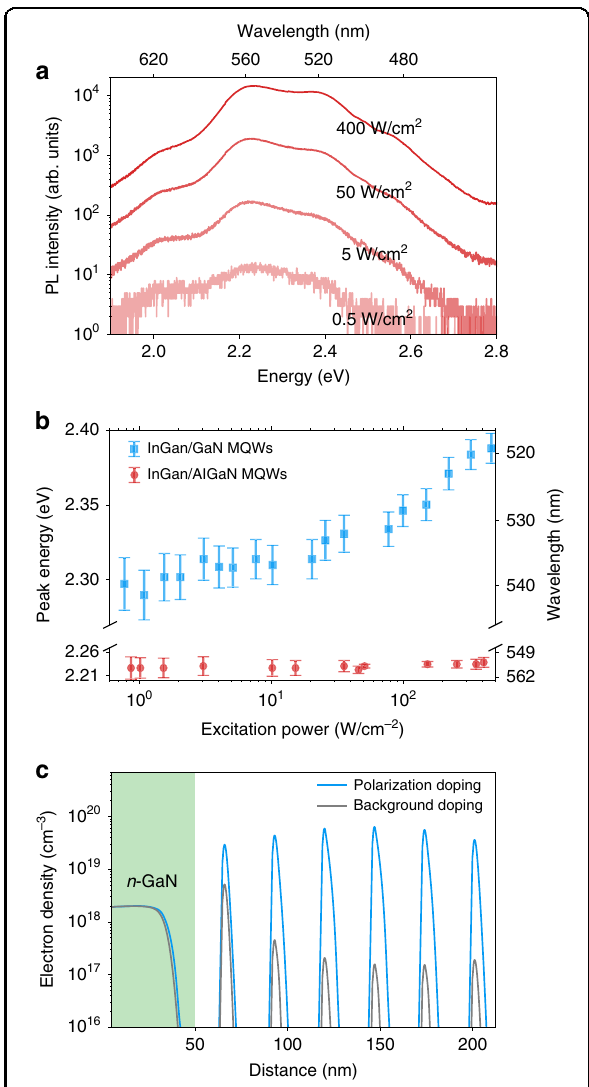
Fig. 3 Comparisons of PL properties of InGaN/(Al)GaN MQWs and screening of QCSE through polarization doping. a Room- temperature power-dependent PL spectra of Sample A at 300 K with excitation power varied by ~3 orders of magnitude. b Emission peak energy vs. excitation power for Sample A (red circles) and Sample B (blue squares). c Calculated electron density distribution with the presence of polarization doping (blue curve)/background doping (gray curve). The green shaded region indicates the n -GaN